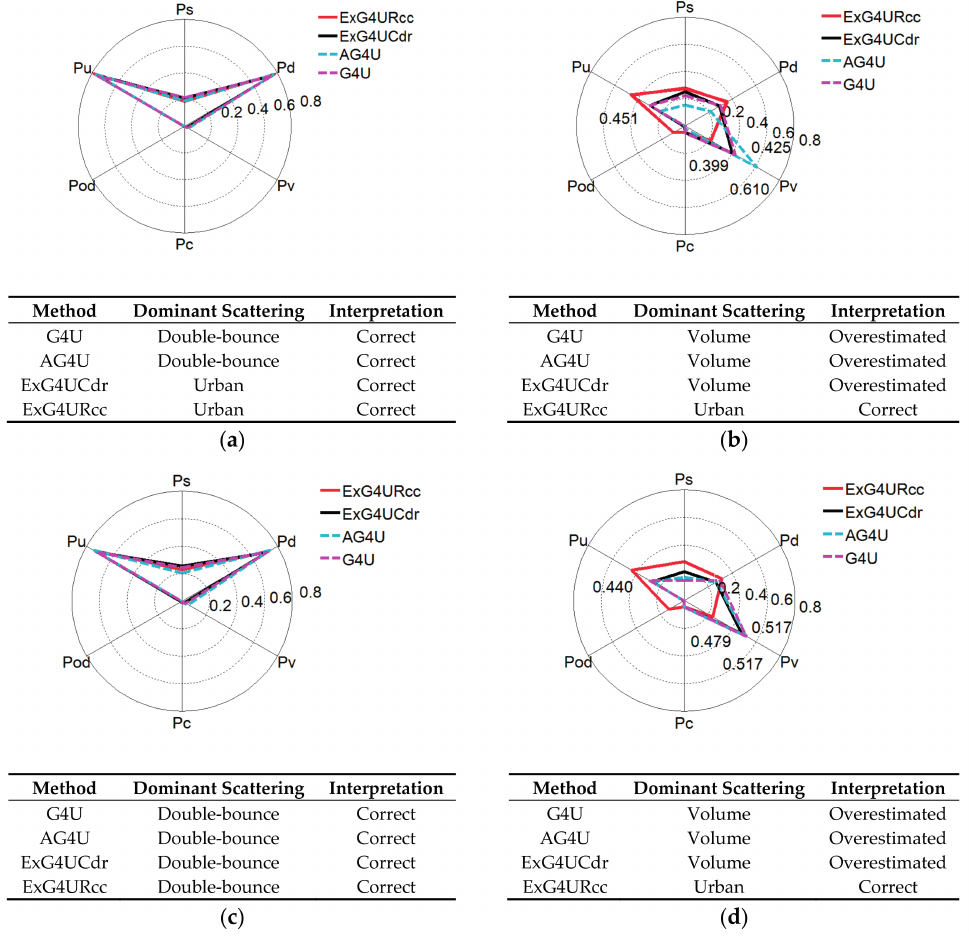
Figure 5. Radar map of averaged power contribution: ( a , b ) results of the white box areas derived from C- and L-band data, respectively; and ( c , d ) results of the white box areas derived from C- and L-band data,